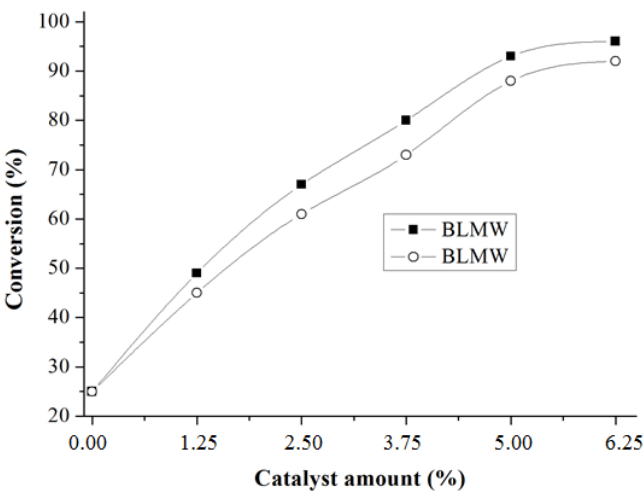
Figure 8. Effect of catalyst amount % fed to the reactor on the % conversion during DDPO esterification with ethanol using catalyst. Reaction conditions: reaction temperature: 160 °C, molar ratio of DDPO:EtOH: 1:30, and reaction time: 2 h.